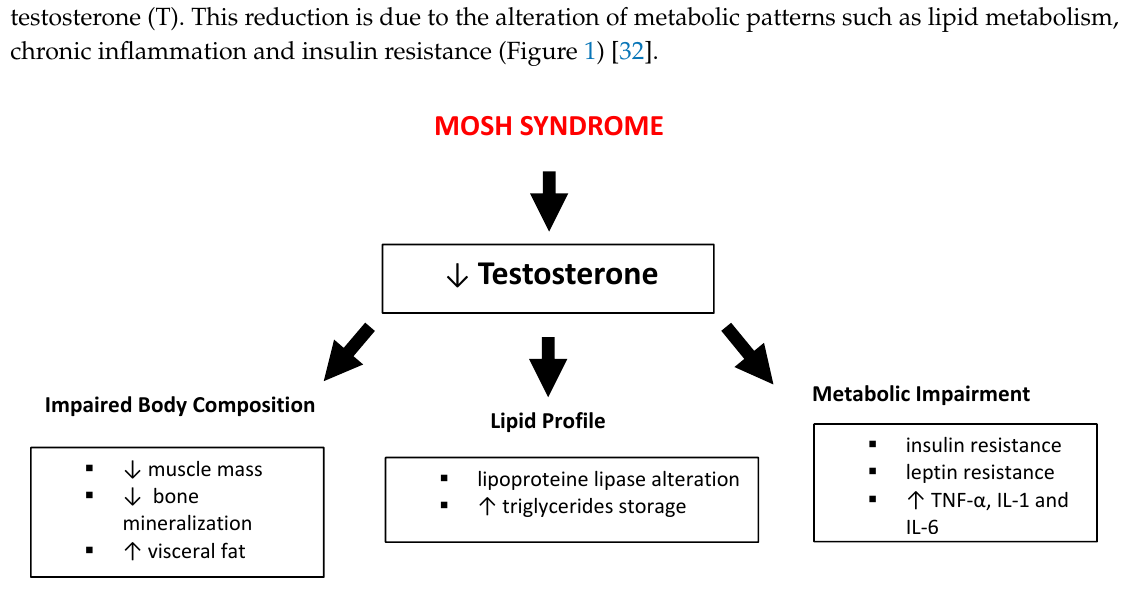
Figure 1. Impact of male obesity secondary hypogonadism (MOSH) syndrome on body composition, lipid profile and metabolic pathways. Abbreviations: TNF- α , tumor necrosis factor- α ; IL, interleukin; ↑ : increase; ↓ :